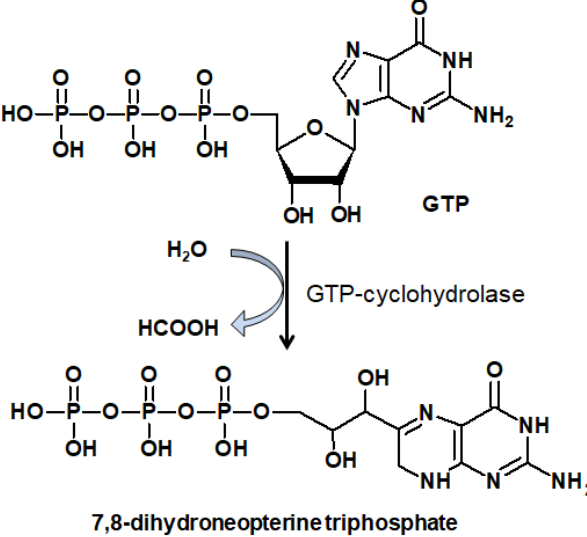
Figure 26. A simplified scheme of guanosine triphosphate (GTP) transformation to 7,8-dihydroneopterinphosphate, a precursor of H 4 Bip [28].